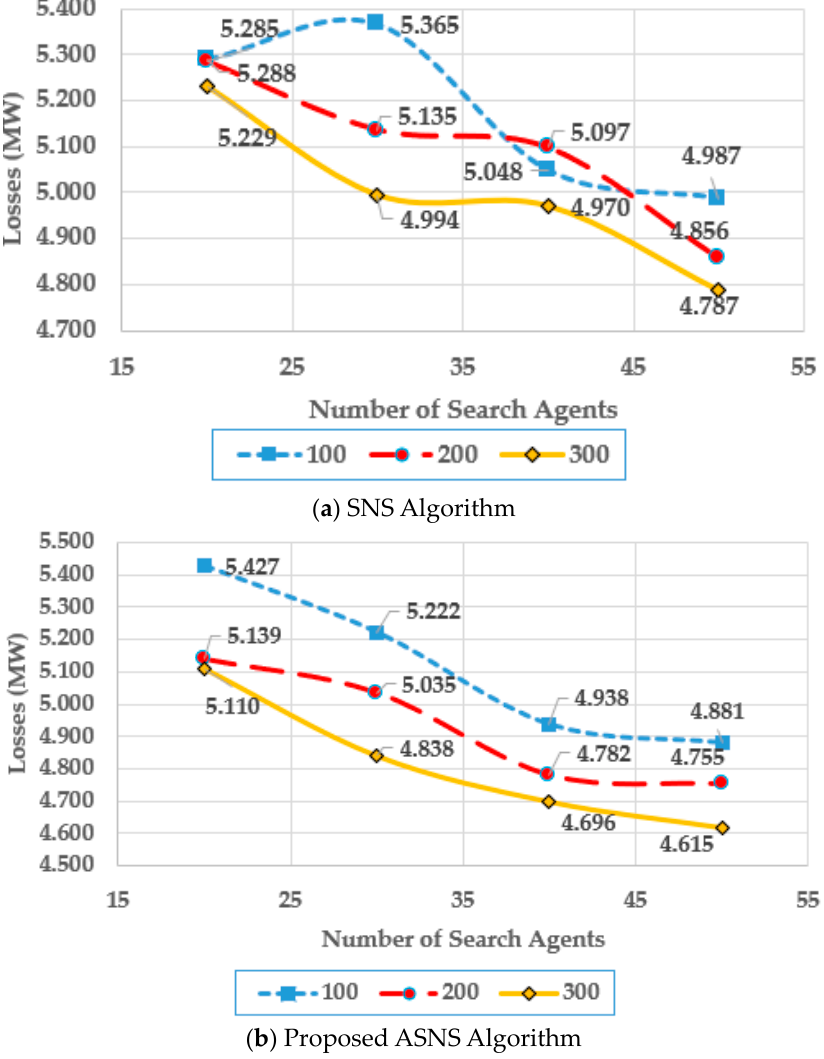
Figure 18. Parameter Tuning of SNS and ASNS Algorithms for Case 1 for the IEEE 30-bus system.